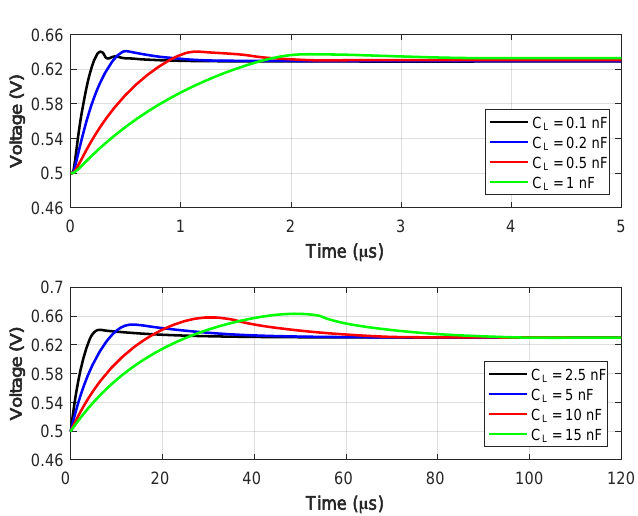
Figure 16. Simulated step response of the proposed amplifier with various load capacitance.